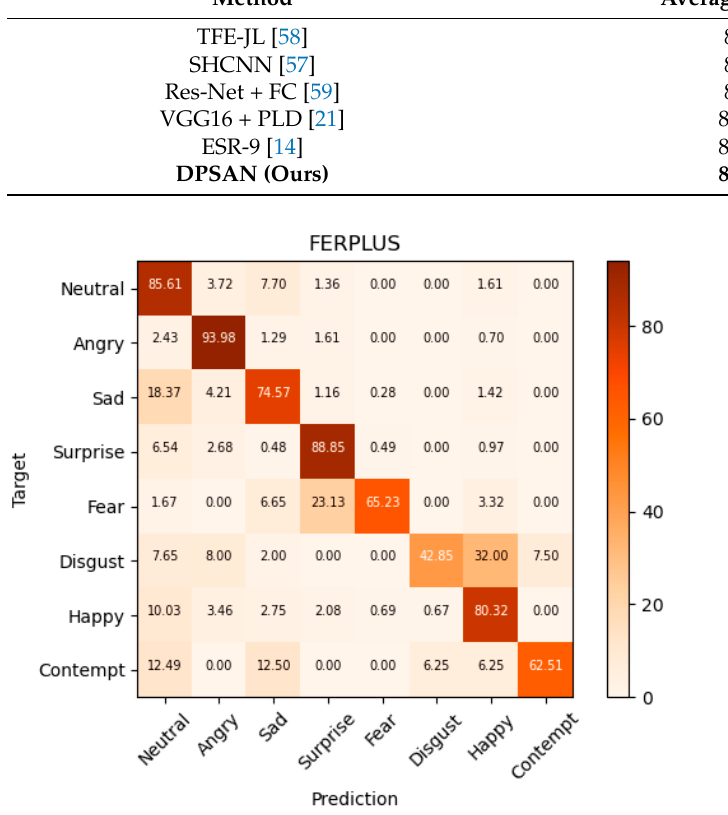
Figure 9. Confusion matrix for DPSAN prediction based on FERPLUS dataset and sentiment label distribution. Table 3. Comparison of DPSAN with other models on the FERPLUS dataset.